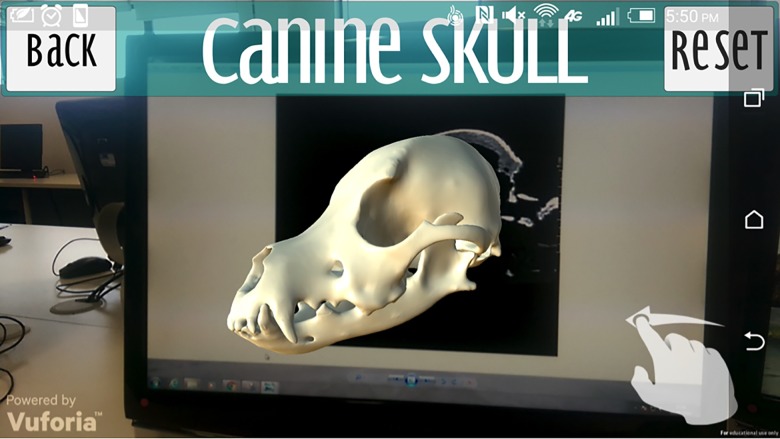
Canine skull menu.